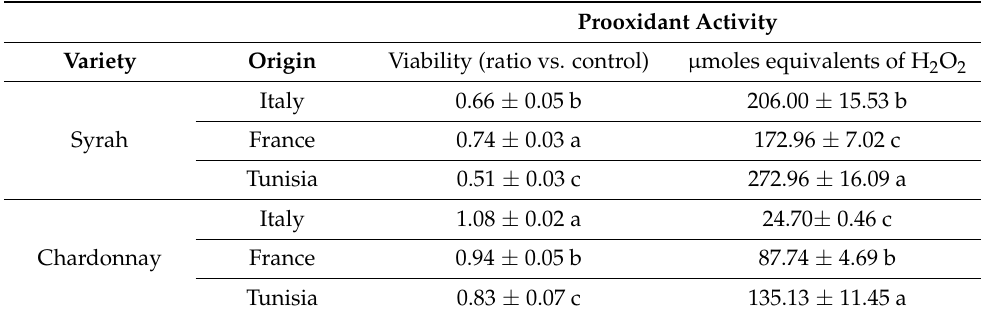
Table 3. Prooxidant activity of 250 mg/mL of Italian, French, and Tunisian Syrah and Chardonnay pomaces extracts on B16F10 melanoma cancer cells.